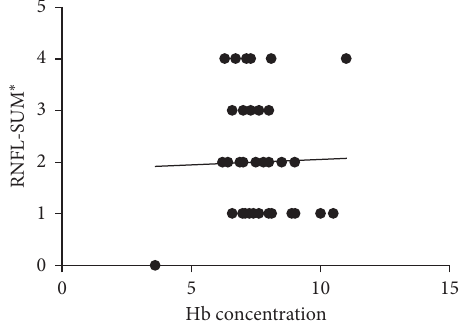
Figure 4: Scatter diagram showing retinal nerve fibre layer (RNFL) thickness and haemoglobin level correlation. Fit plot for the retinal nerve fibre layer vs. haemoglobin